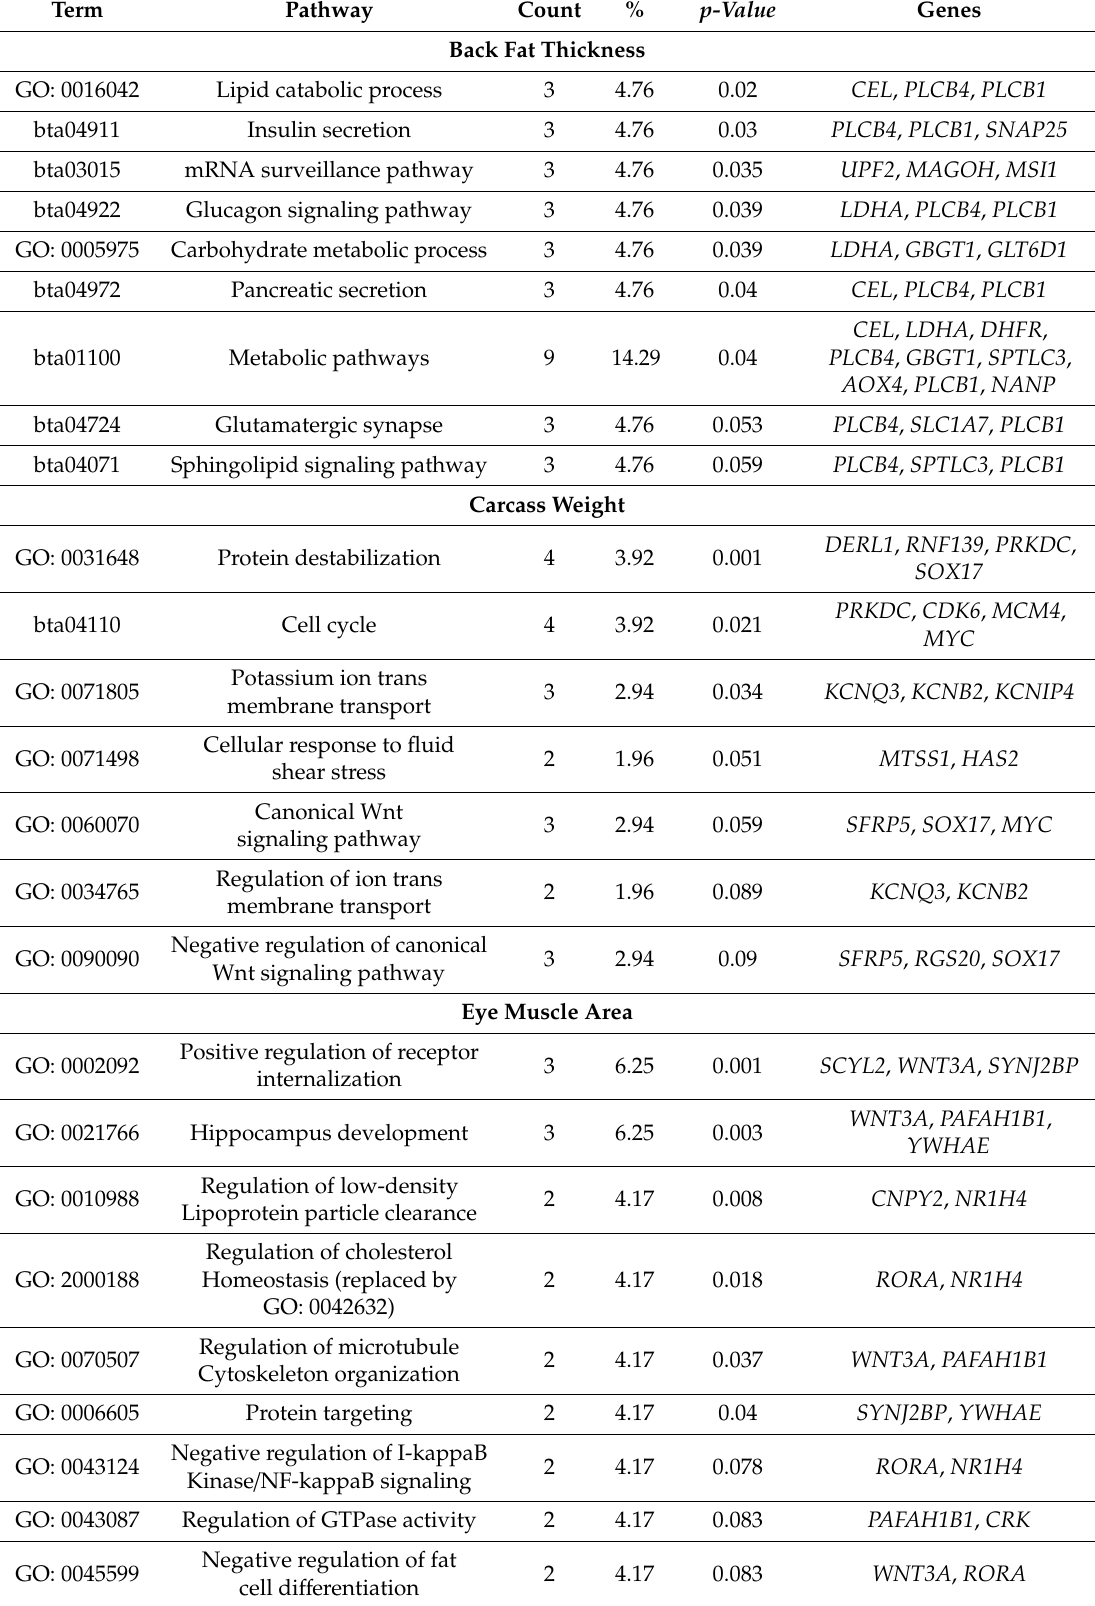
Table 3. DAVID functional annotation for genes and their associations with pathways.